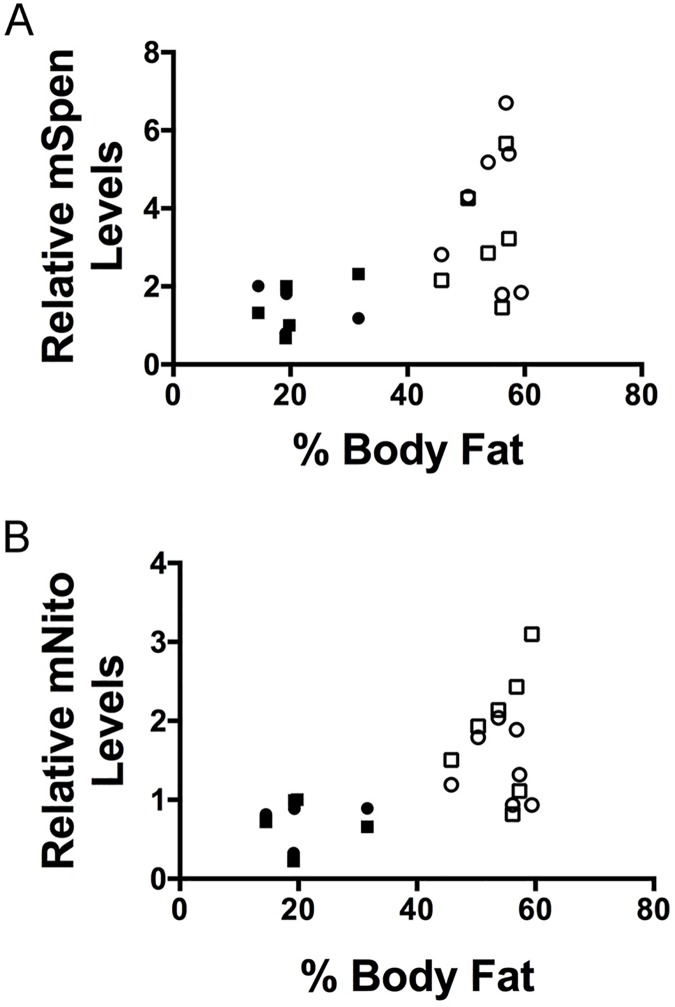
Spen and Nito transcript levels are modulated by body fat levels in mouse adipose tissue.(A)mSpen levels with respect to percent body fat in mice fed either a normal chow (solid shapes, n = 5) or HFD (open shapes, n = 7). Two technical replicates per sample (circles vs. squares). P value and correlation coefficient obtained by unpaired two-tailed t test from the average of the technical repeats. P < 0.05, r = 0.65. (B)As in A, mNito levels with respect to percent body fat in mice. P < 0.01, r = 0.74.